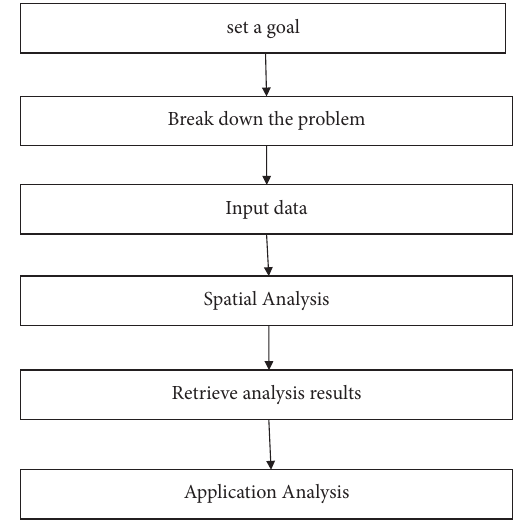
Figure 1: main steps and technical flow chart of spatial analysis.